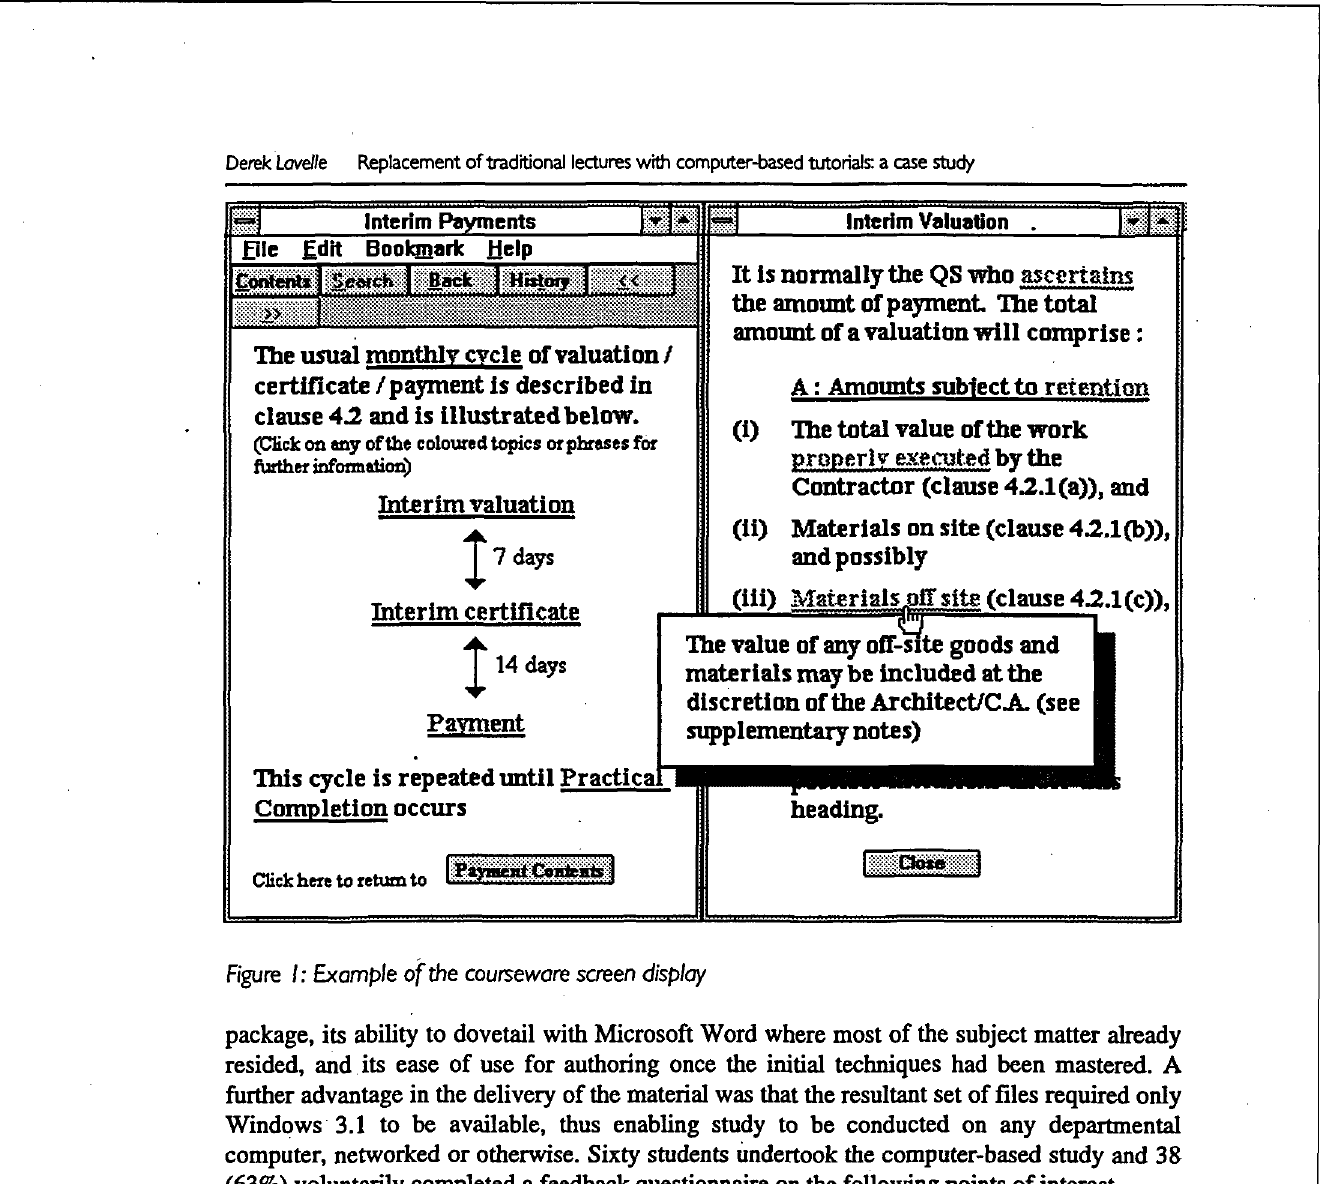
Figure J: Example of the courseware screen